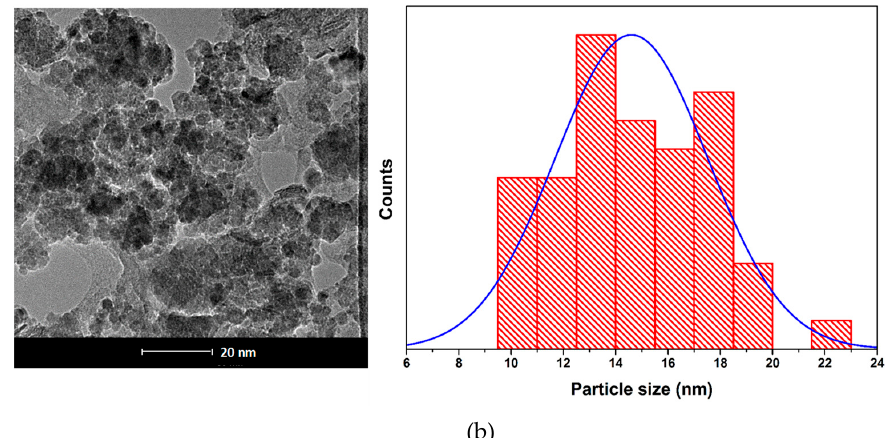
Figure 2. Transmission electron microscopy images and particle size distributions. ( a ) CuNPs; ( b ) FeNPs.